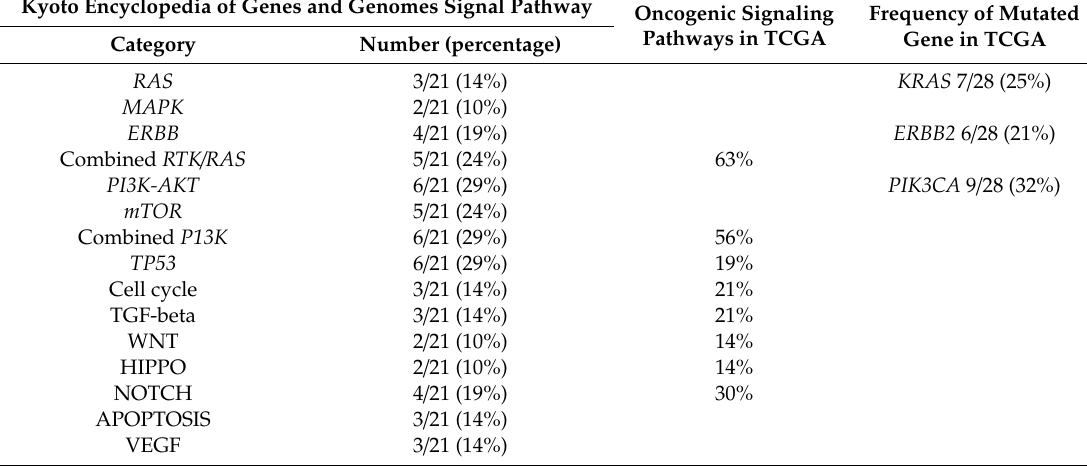
Table 1. The associated Kyoto Encyclopedia of Genes and Genomes signal pathway and comparative data from The Cancer Genome Atlas